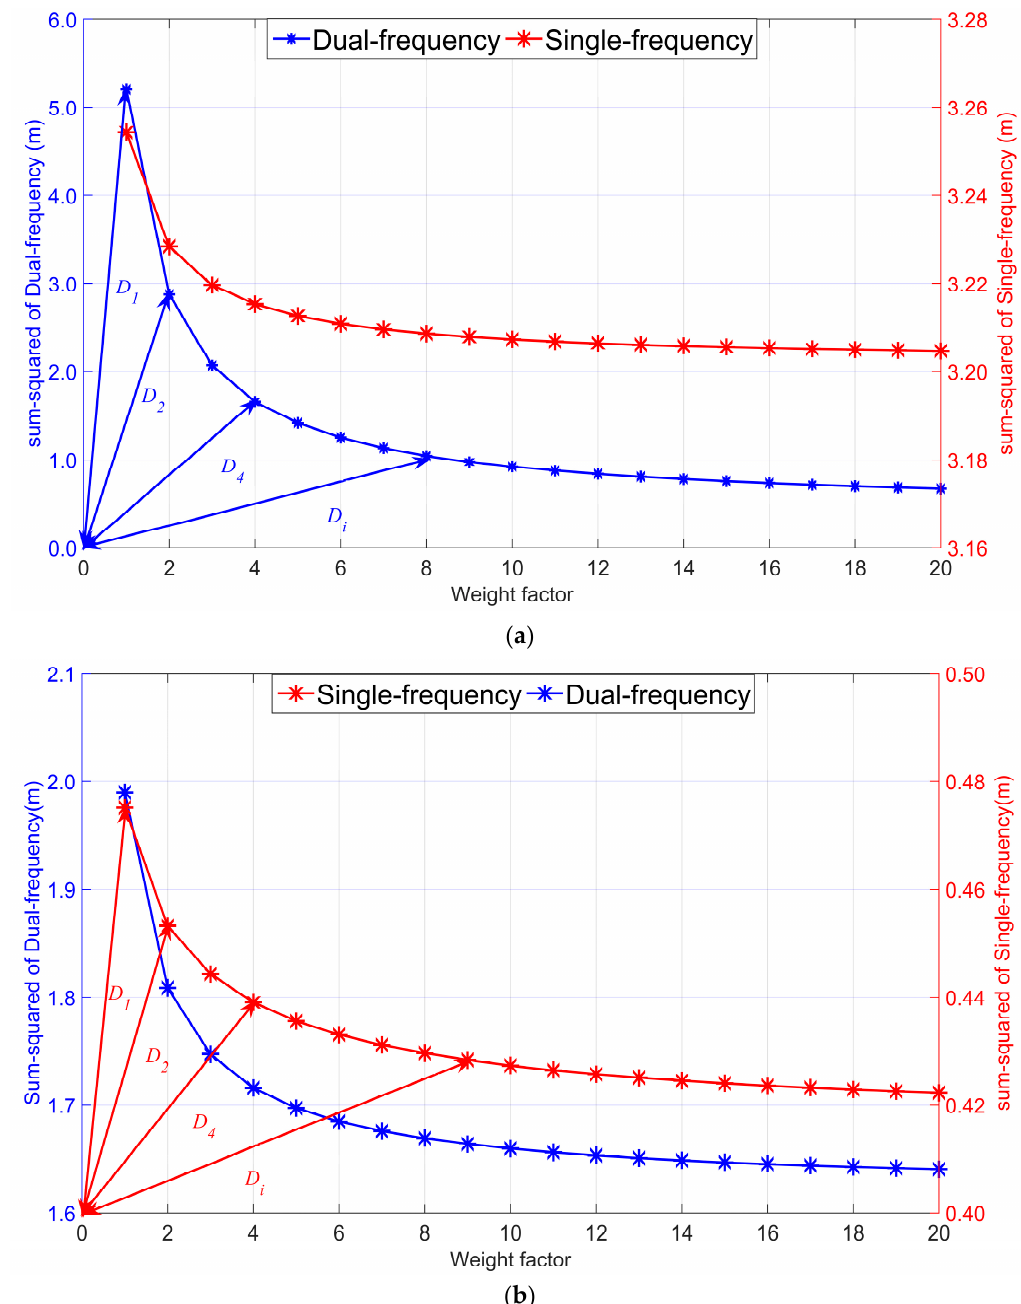
Figure 2. Relationships between the weight factors and the post-fit weighted sum-squared residuals for kinematic ( a ) and static ( b